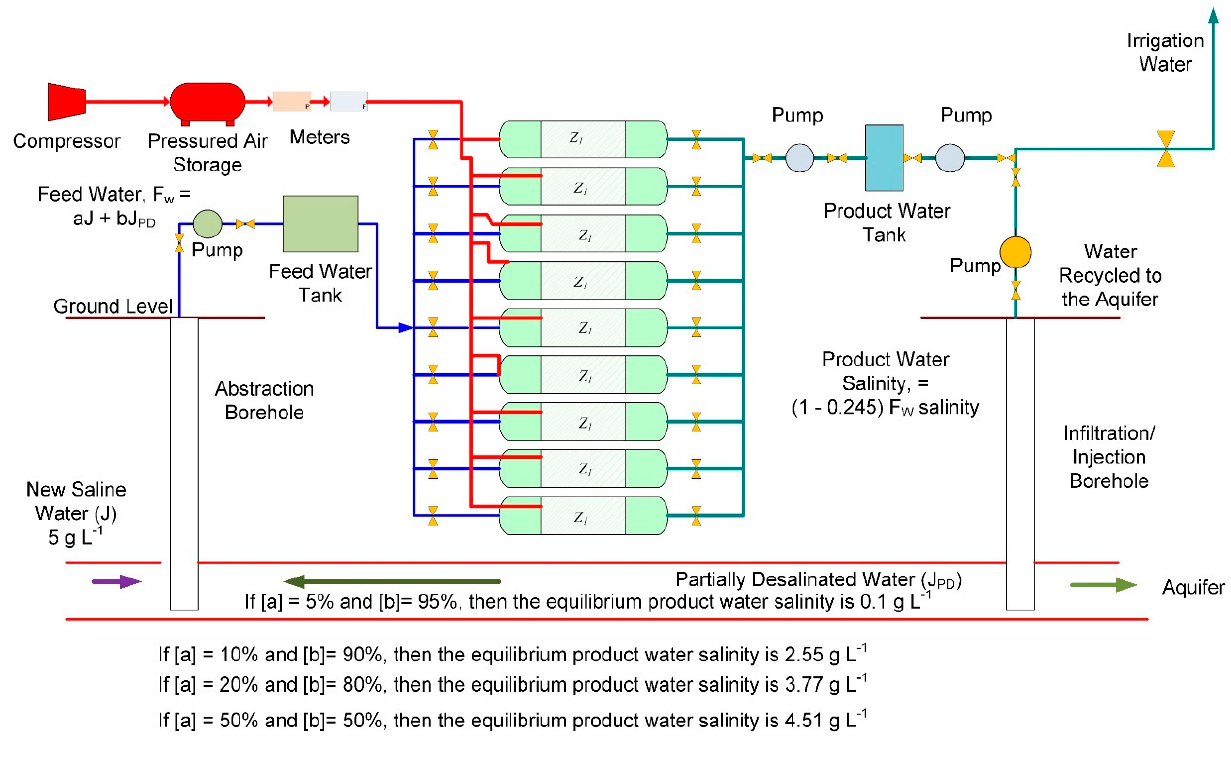
Figure 24. Partial desalination of an aquifer. Modelled equilibrium salinities in the aquifer, where the initial aquifer salinity is assumed to be 5 g L − 1 .